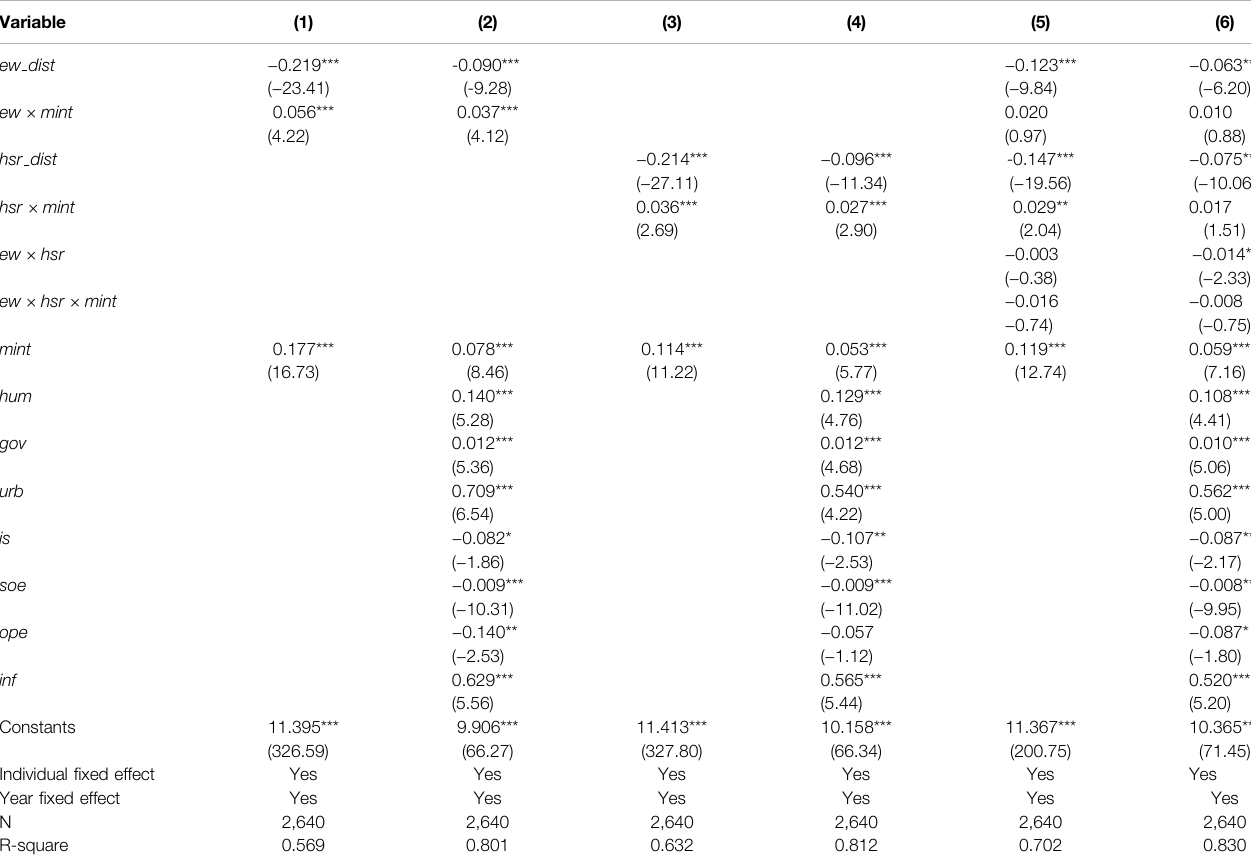
TABLE 3 | Rapid transit development, market integration, and urban economic growth.